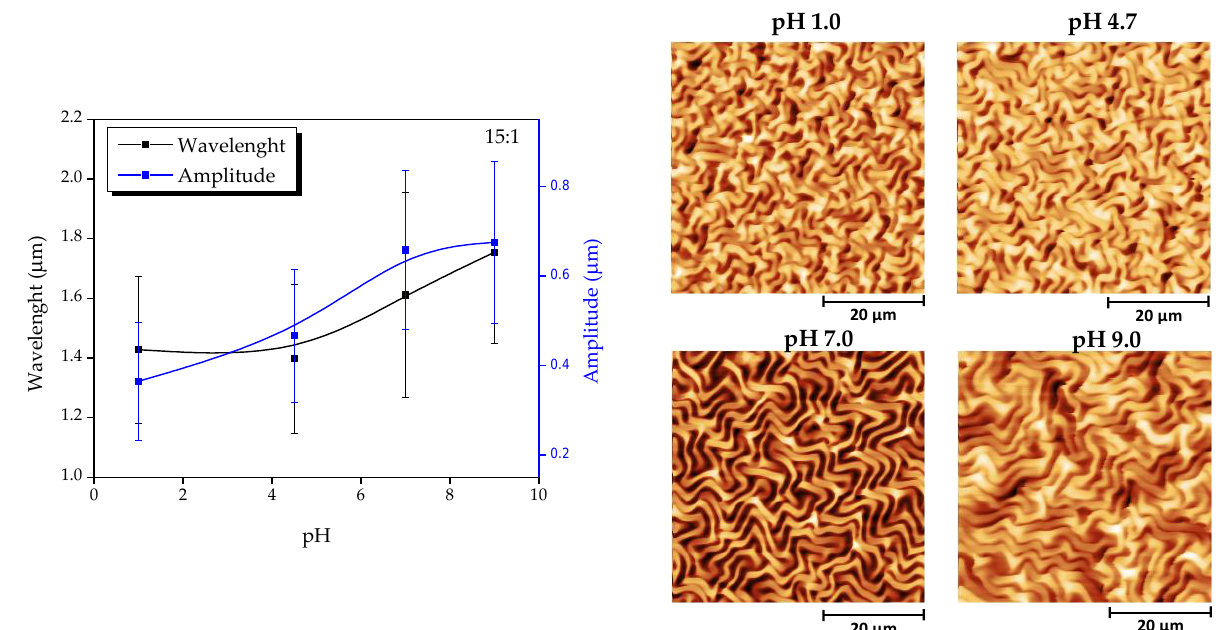
Figure 8. Right: Evolution of the wrinkle characteristics (wavelength and amplitude) for the wrinkled hydrogel 15:1 as a function of Table 1. Obtained at different pH values.